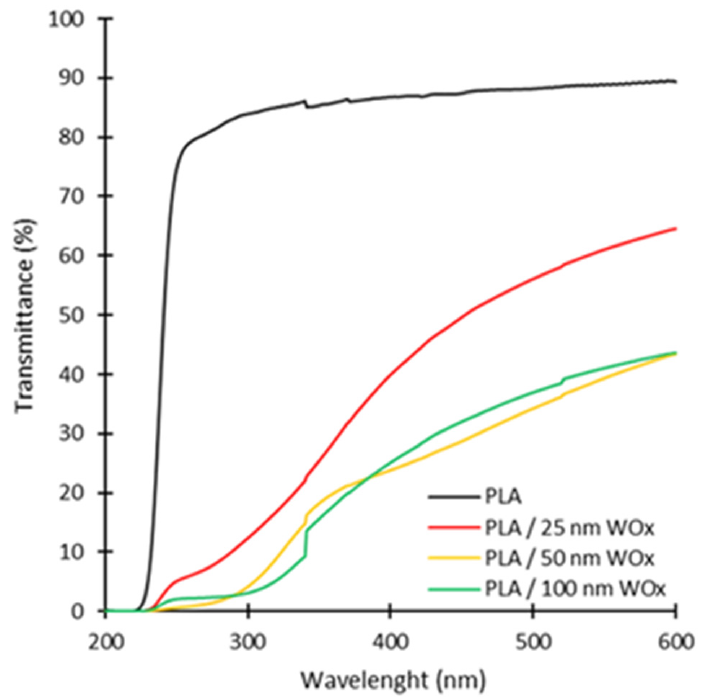
Figure 7. UV-vis absorption spectra of PLA and PLA/WO x . Table 2. Percentage of light transmittance (%) in UV and visible regions for PLA and PLA/WO x .